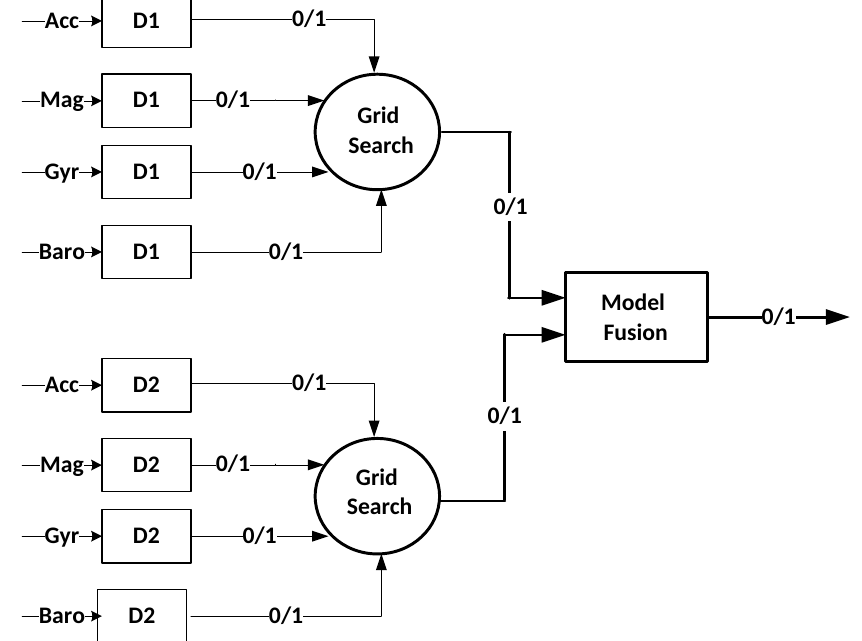
Figure 4. Super-bagging method for fusion of all sensors (the grid search is only for sensor fusion, in case of one sensor such as an accelerometer there is no grid search but late fusion), M D represent the machine-learning models trained on D 1 and D 2